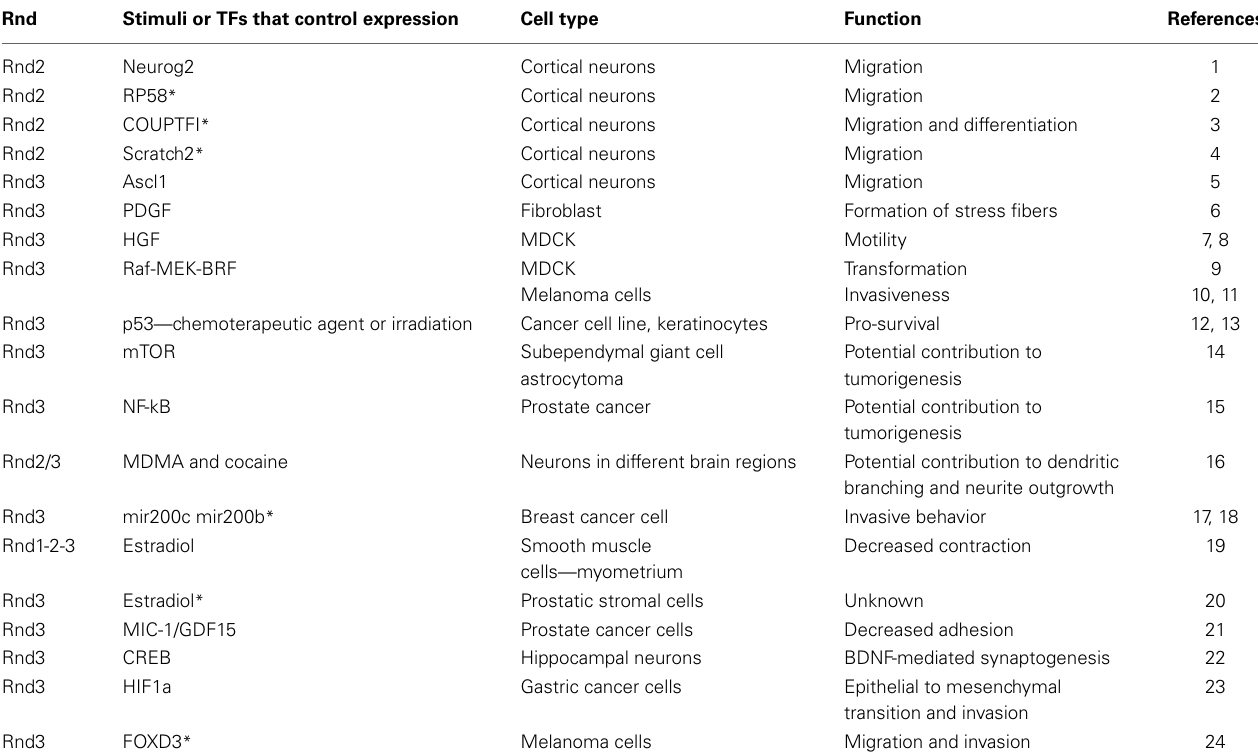
Table 2 | Mechanisms regulating Rnd